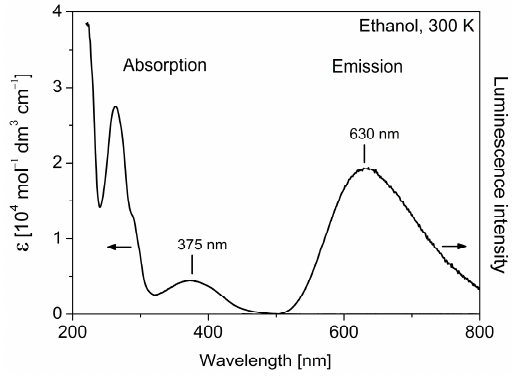
Figure 3. Absorption and luminescence spectra of 1 in ethanol at ambient temperature. Table 2. Photophysical data for complexes 1 – 3 at ambient temperature in ethanol.